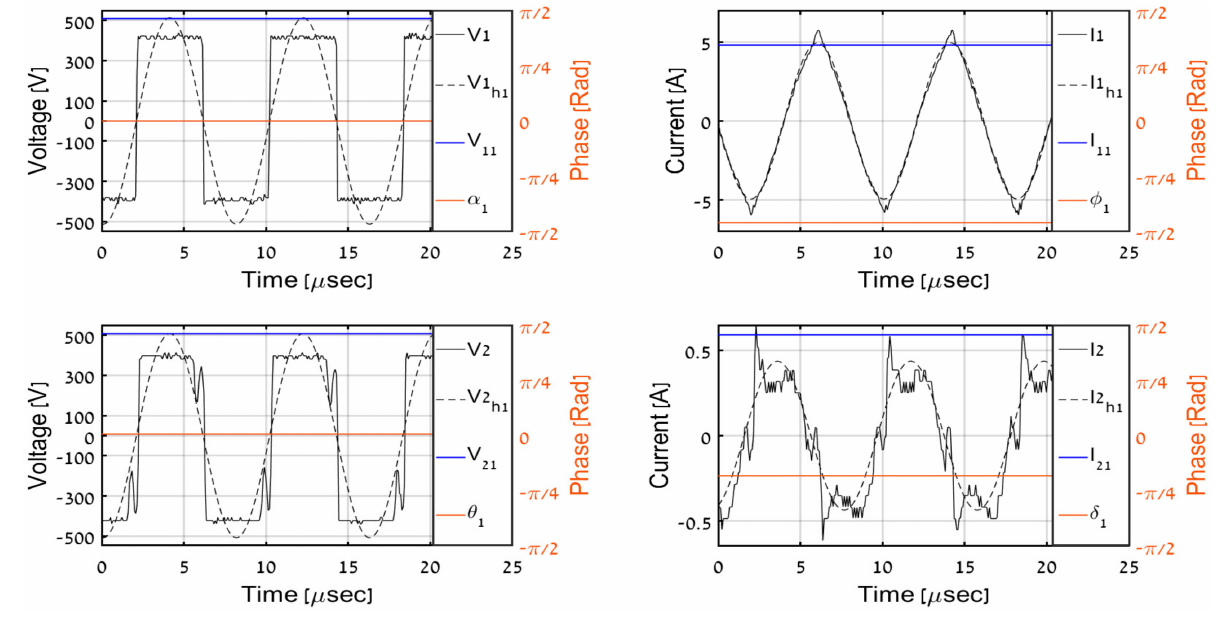
Figure 17. Experimental results, P O = 100 W.